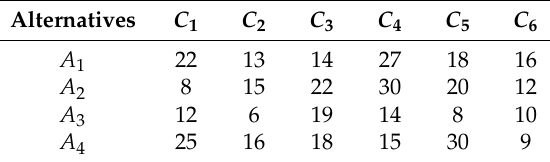
Table 2. Order inducing